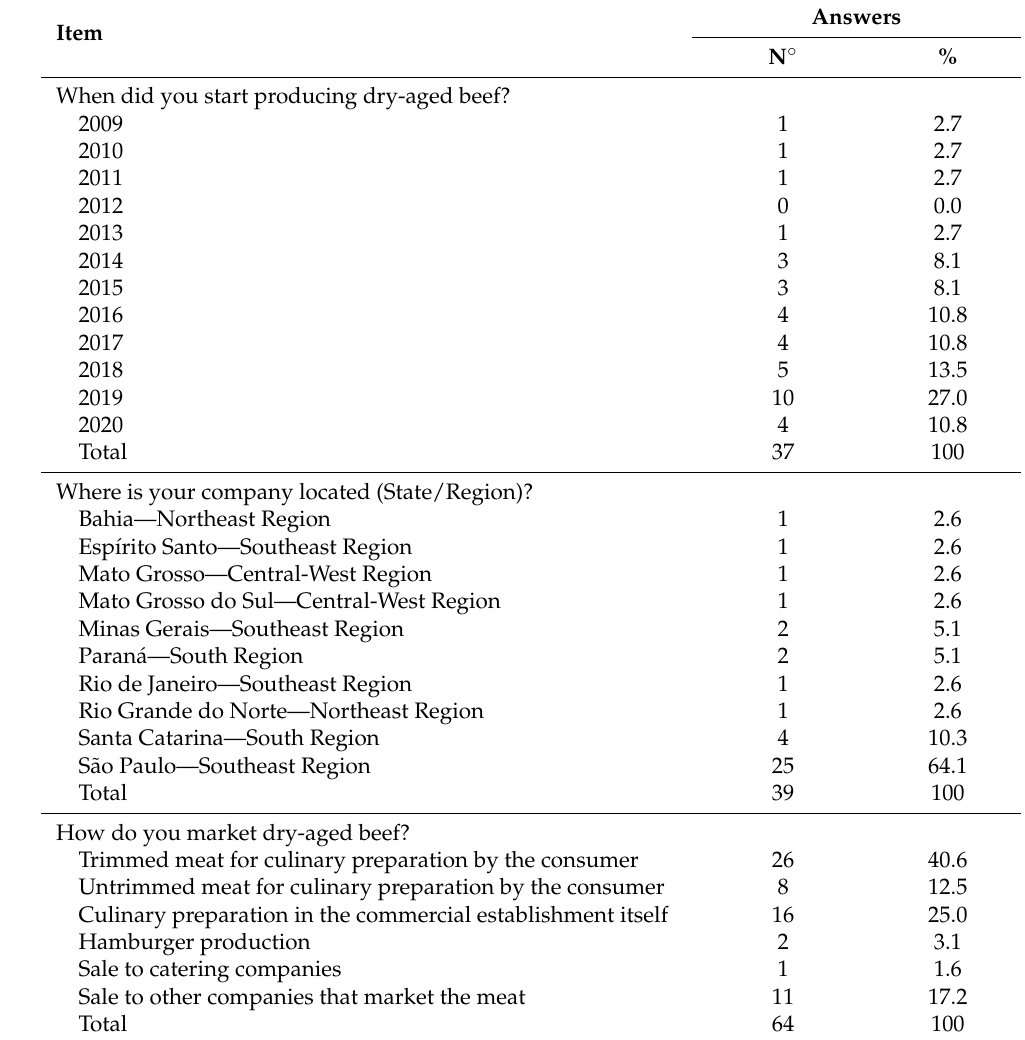
Table 1. General identification of enterprise that produce dry-aged beef in